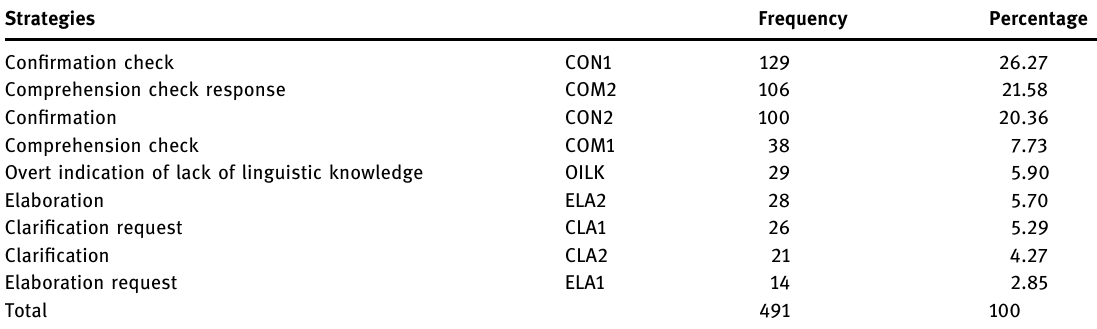
Table 2: Total frequency of the strategies for negotiation of meaning ranked according to their relevance Strategies